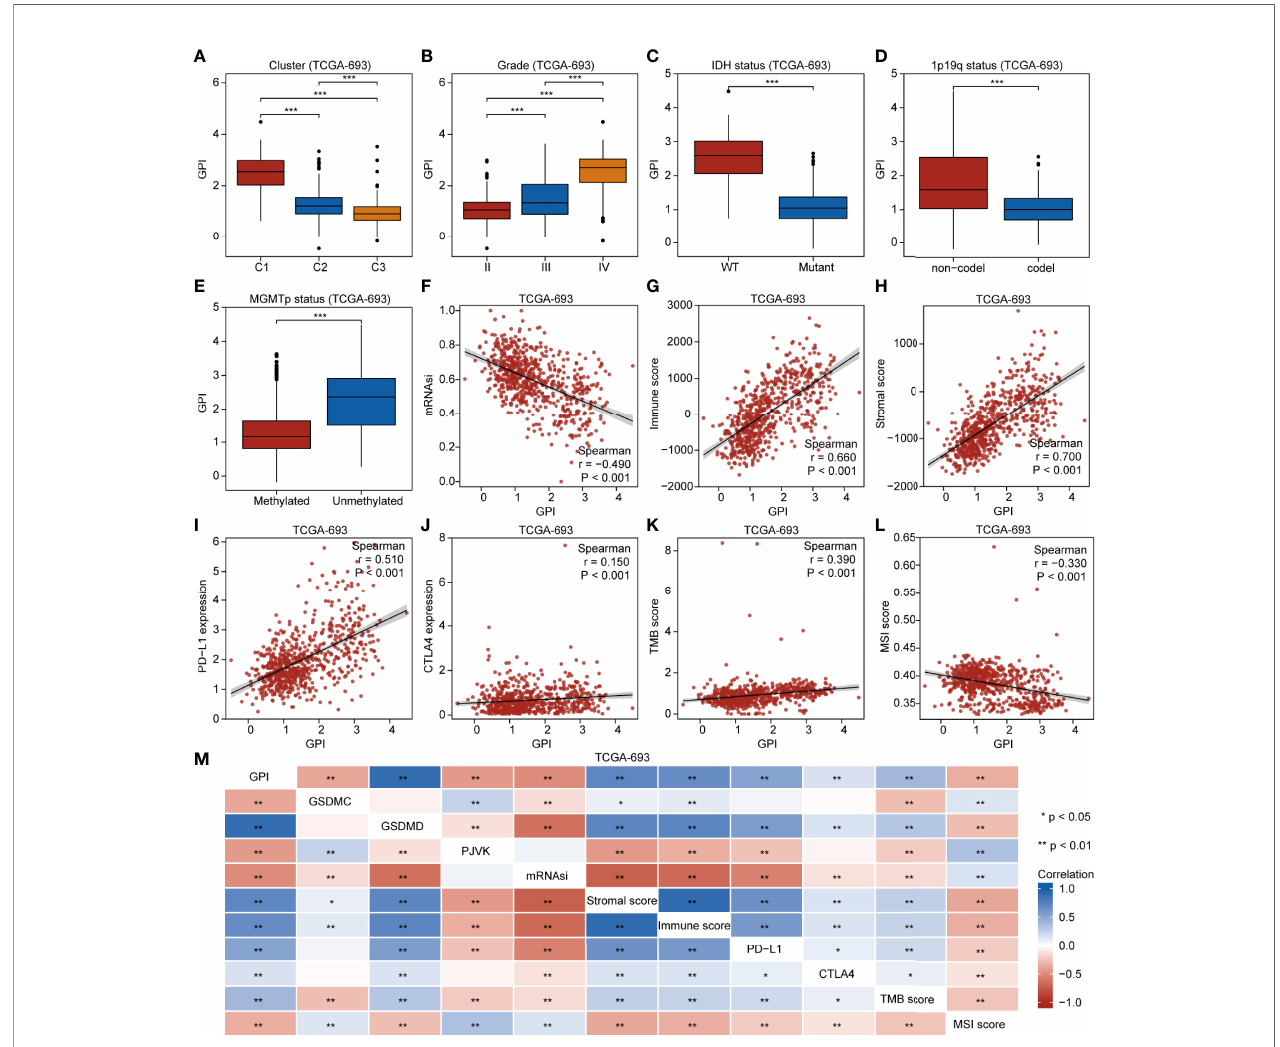
FIGURE 7 | GPI is correlated with clinical characteristics, molecular features, and immunity in glioma. Boxplots showing comparison of GPI in different pyroptosis subtypes (A), grades (B) , IDH mutation statuses (C) , 1p19q codeletion statuses (D) , and MGMT -promoter methylation statuses (E) . Scatterplots showing correlations of GPI with mRNAsi (F) , immune score (G) , stromal score (H) , PD-L1 expression (I) , CTLA4 expression (J) , TMB score (K) , and MSI score (L) . (M) Heatmap indicating correlation between GPI, GSDMC expression, GSDMD expression, PJVK expression, mRNAsi, immune score, stromal score, PD-L1 expression, CTLA4 expression, TMB score, and MSI score. *P<0.05; **P <0.01; ns, not signi fi